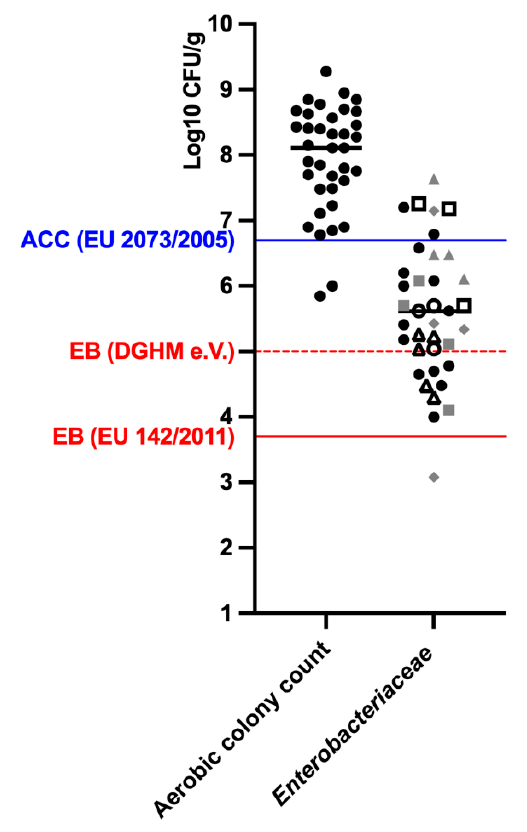
Figure 3. Microbial load (total aerobic bacteria and Enterobacteriaceae log 10 CFU/g) of 37 RMBDs. The red solid line represents the threshold for aerobic colony count in animal by-products (EC No 2073/2005), and the red dashed line represents the threshold for Enterobacteriaceae in raw beef and poultry meat intended for human consumption (German Society for Hygiene and Microbiology— DGHM e.V.). In relation to Enterobacteriaceae , complementary RMBDs are marked in grey and complete RMBDs in black. Full dot—adult dog ( n = 8); empty dot—puppy ( n = 1) squared dot— adult and puppy ( n = 3); triangle—adult cat ( n = 4); reverse squared dot—dog and cat (adult + growth, n = 1). CFU, colony-forming units; ACC, Aerobic Colony Count; EB, Enterobacteriaceae.